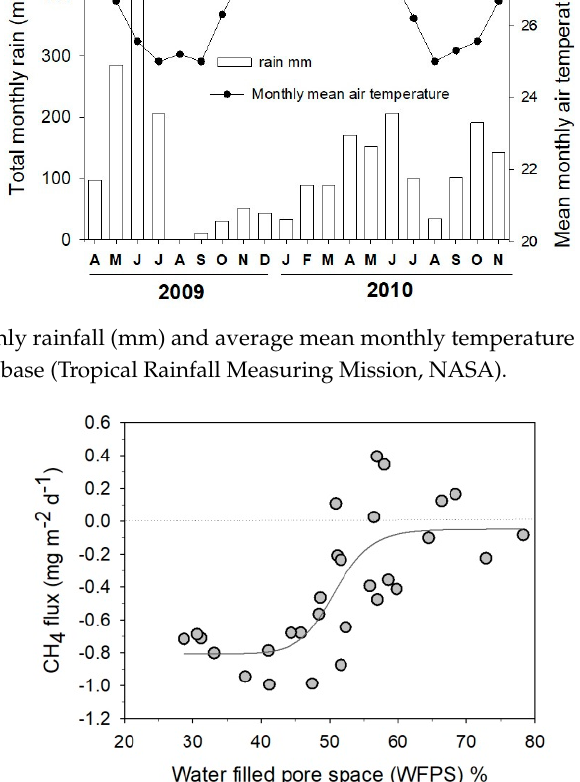
Figure 3. Upland site, average ( n = 8) daily CH 4 fluxes plotted vs. soil water-filled pore space (%) estimated from volumetric water content measured inside the chambers at the end of gas sampling. Equation of the fitting curve: y = − 0.81 + 0.76/[1 + (x/ − 50.78) − 19.23 ], R 2 = 0.58, p < 0.0001. Soil CH 4 fluxes were measured in the downhill site of Ankasa Park from May to November 2010. Figure 4 shows that the daily average CH 4 fluxes were significantly higher than those observed